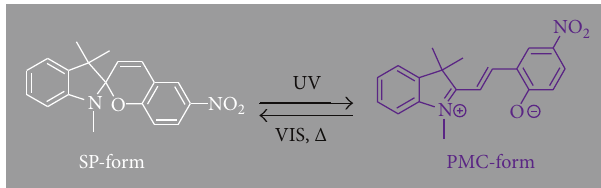
Figure 1: Reversible photoisomerization of spiropyran dye 1 󸀠 ,3 󸀠 ,3 󸀠 -